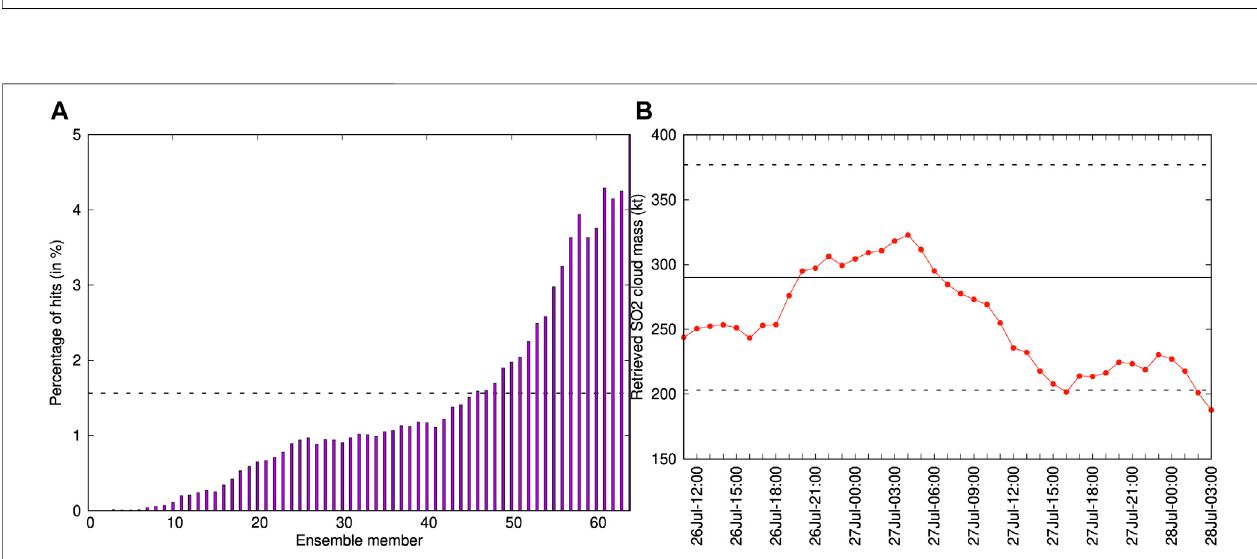
FIGURE5|(A) Observationsrankhistogram(Talagranddiagram)forthe64-memberAmbaeensemblerun.Thehorizontaldashedlineat1/64 (cid:2) 1.56 % indicatesa perfectly consistent forecast, with all its members being equally represented against observations. (B) time series of SO 2 AHI retrieved cloud mass. The solid horizontal line at 290 kt shows the reference run and the dashed lines indicate the ± 30 % ensemble spread in emission rate.